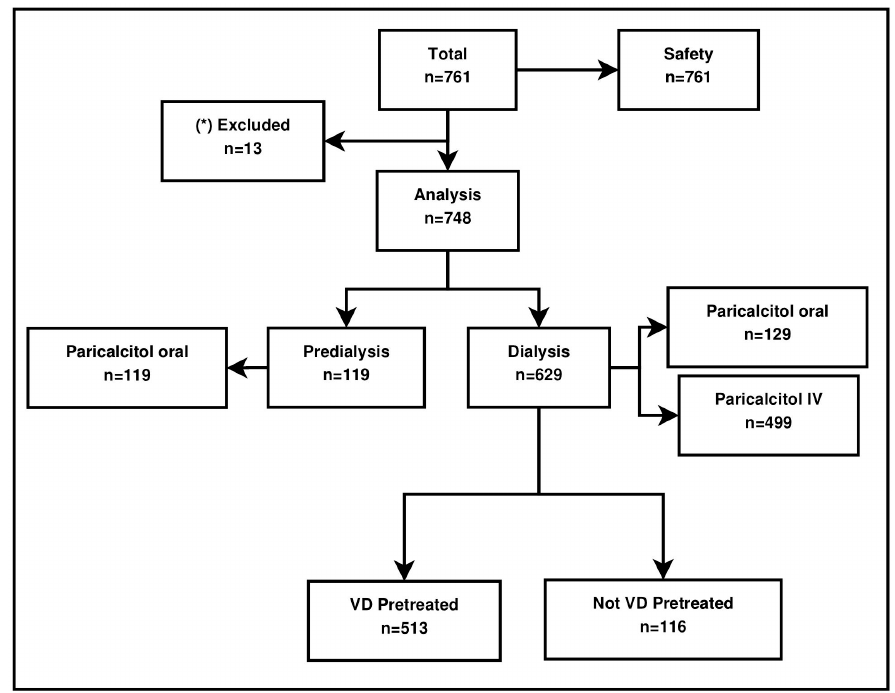
Figure 1. Study population. IV, intravenous; VD, vitamin D. * Insufficient follow-up data